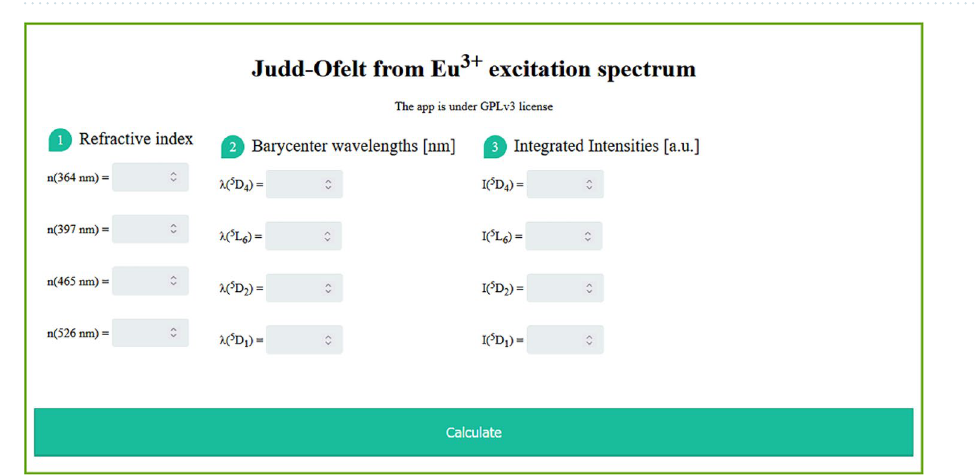
Figure 3. Web application for calculating JO parameters from an excitation spectrum, which is available at https:// omasg roup. org/ judd- ofelt- from- excit ation- spect rum- of-